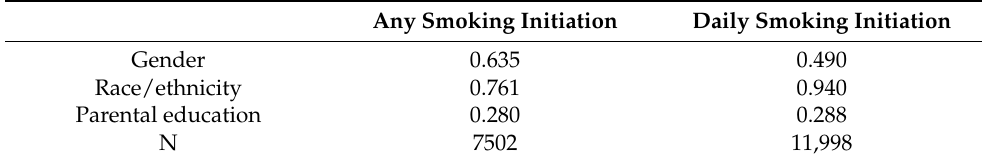
Table 3. Unadjusted additive p -values associated with interaction terms between media campaign exposure and gender, race/ethnicity, and parental education for any smoking initiation, and daily smoking initiation at modal age 19/20, monitoring the future longitudinal sample, baseline year 2001–2015. Results reflect imputed data (m =